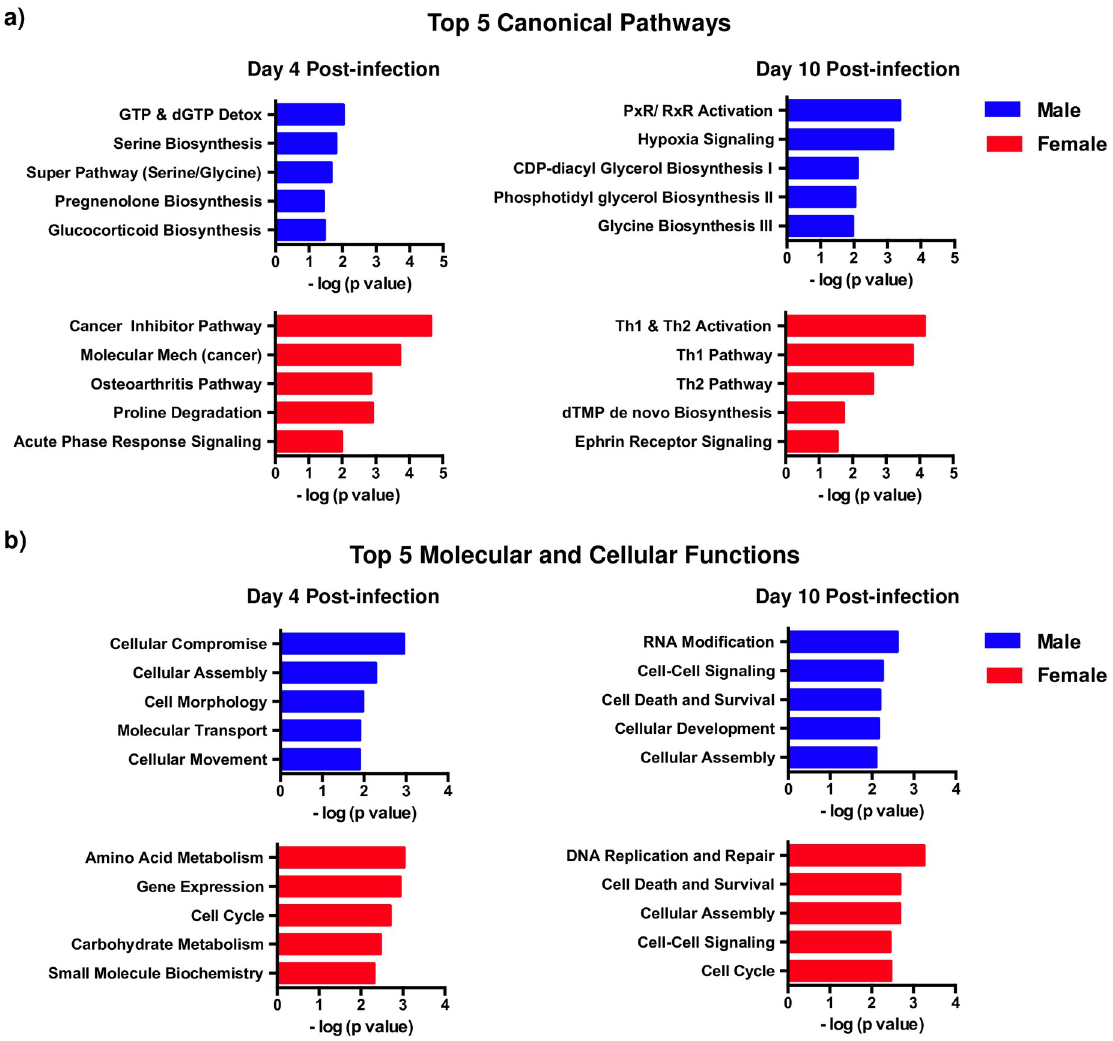
Fig 3. Canonical and biological pathways in memory CD4 T cells diverge in male and female macaques during acute SIV infection. Statistically significant genes that were differentially regulated between male and female macaques were used to pathway analysis using Ingenuity Pathway Analysis software. (a) Top 5 canonical pathways in (n = 4) and female (n = 4) macaques at day 4 and 10 post SIV infection (PI), and (b) top 5 molecular and cellular functions in (n = 4) and female (n = 4) macaques at day 4 and 10 PI. Each animal’s day 0 sorted CM CD4 T cell sample was used to normalize the same animals day 4 and 10 post SIV infection sorted samples.